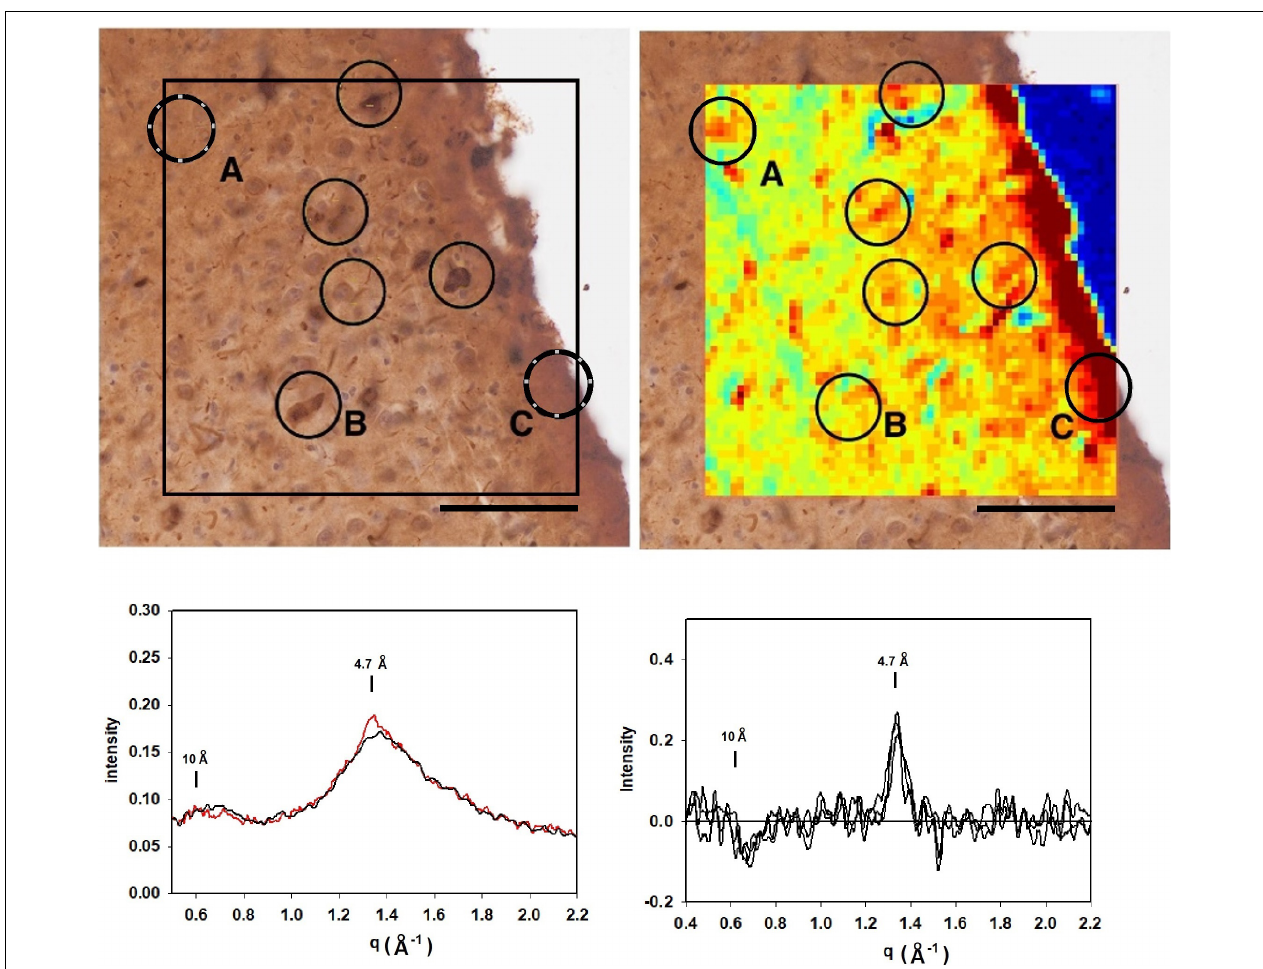
FIGURE 6 | (top left) Image of a section of the entorhinal cortex of a subject with frontotemporal lobar degeneration with tau pathology (FTLD-tau) stained for tau. Comparison with the mapping of x-ray intensities (top right) identified numerous features common to both images. Analysis of the scattering patterns from these features indicated that most exhibited weak enhancement perhaps due to non-fibrillar tau ( Figure 5 ) although most were much weaker (bottom right) . Feature exhibited a sharp 4.7 Å feature indicative of the presence of a cross- β structure (bottom left) . Given the complete absence of A β in this region (by immunostaining), this feature is interpreted as arising from fibrillar tau